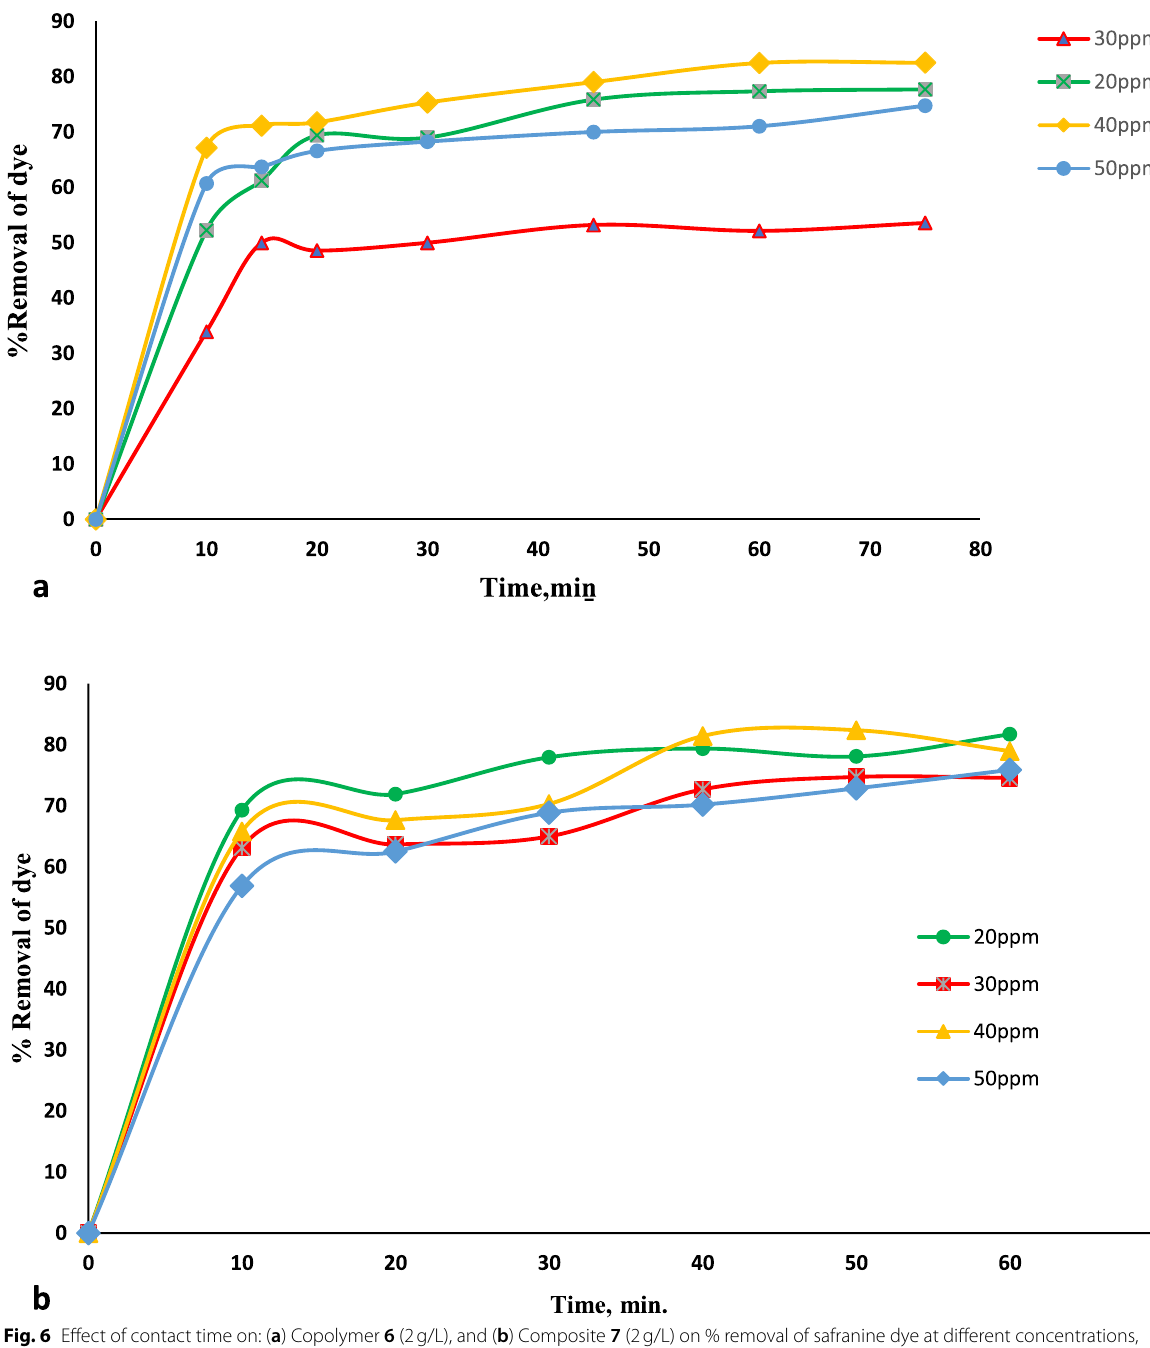
Fig. 6 Effect of contact time on: ( a ) Copolymer 6 (2 g/L), and ( b ) Composite 7 (2 g/L) on % removal of safranine dye at different concentrations, pH 7.2, 25 =